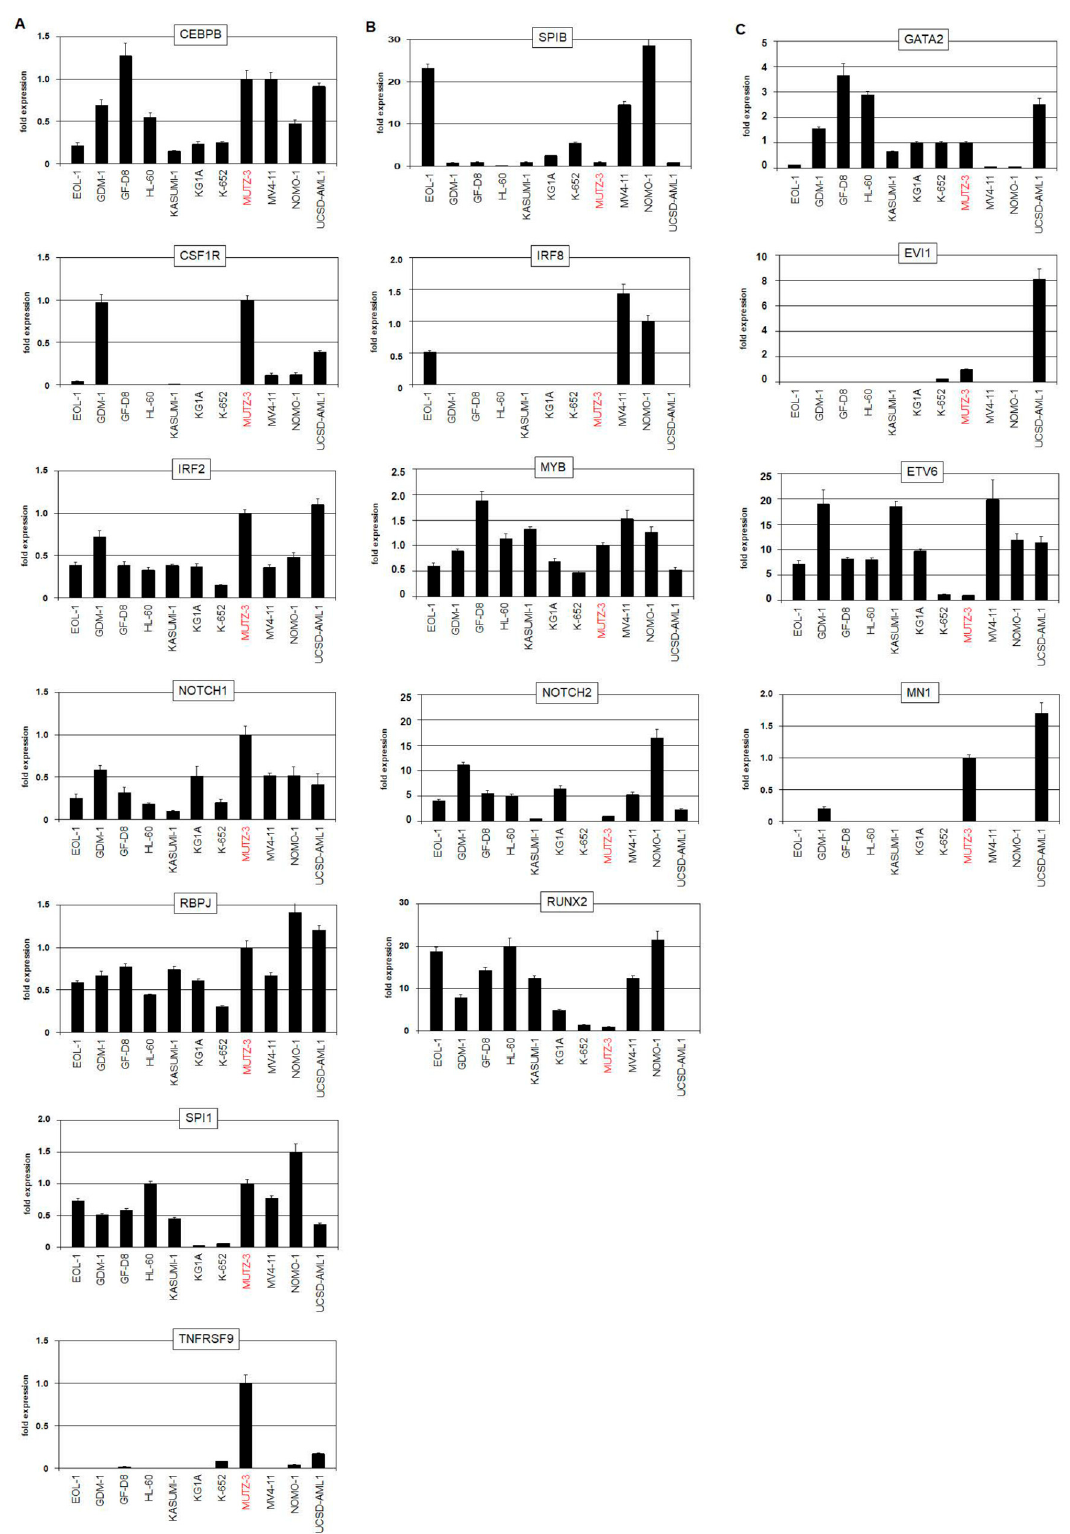
Figure 4. RQ-PCR analyses in MUTZ-3 and AML control cell lines. ( A ) RQ-PCR analyses of cDC-specific genes including CEBPB, CSF1R, IRF2, NOTCH1, RBPJ, SPI1, and TNFRSF9. ( B ) RQ-PCR analyses of pDC-specific genes including IRF8, SPIB, MYB, NOTCH2, and RUNX2. ( C ) RQ-PCR analyses of GATA2, EVI1, ETV6, and MN1 which are targeted by chromosomal aberrations in MUTZ-3 and UCSD-AML1. MUTZ-3 is highlighted in